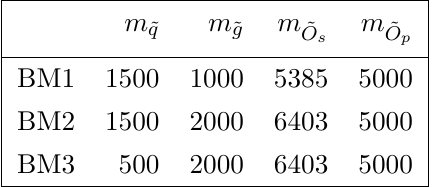
Table 2. Benchmark points. Assuming uni(cid:12)ed squark masses and the sgluon masses apply only to the MSSM. All masses are given in